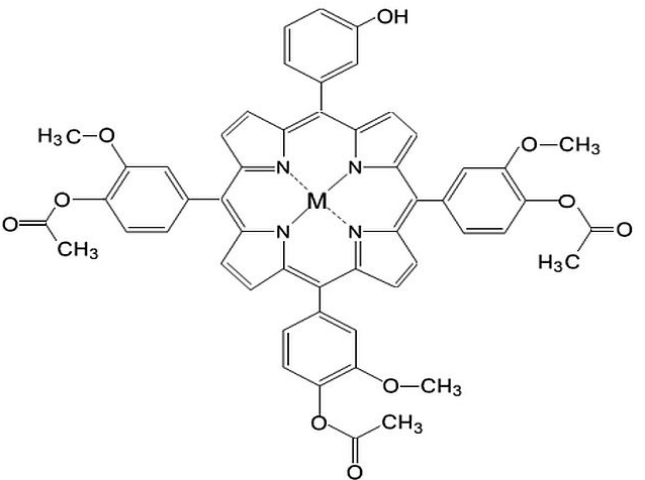
Figure 1. General structures of M(II)-5-(3-hydroxyphenyl)-10,15,20-tris-(4-acetoxy-3- methoxyphenyl)porphyrin, M = Cu,